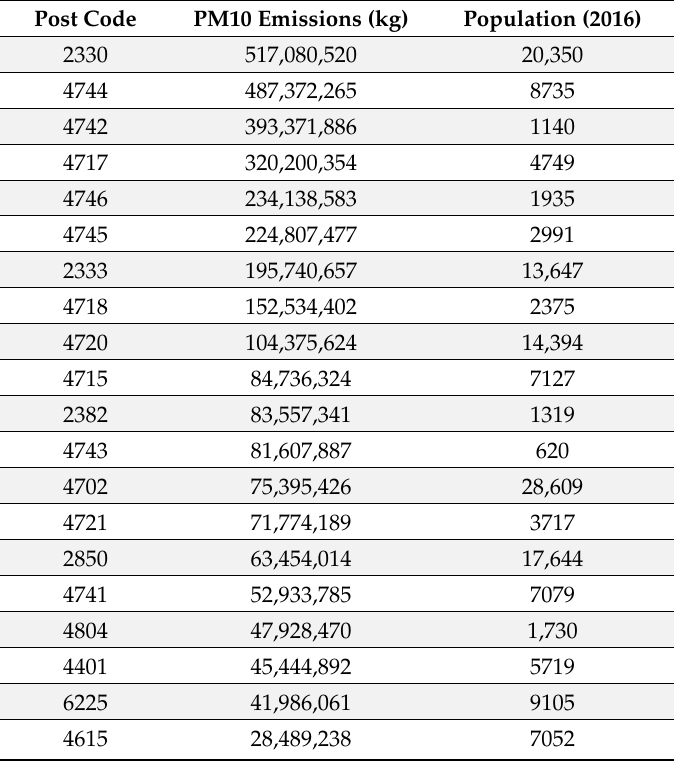
Table 2. Post codes and populations corresponding to the 20 locations with highest PM10 emissions from coal mining sites (post codes starting with: 4 ... : Qld; 2 ... : NSW; 6 ... : WA).